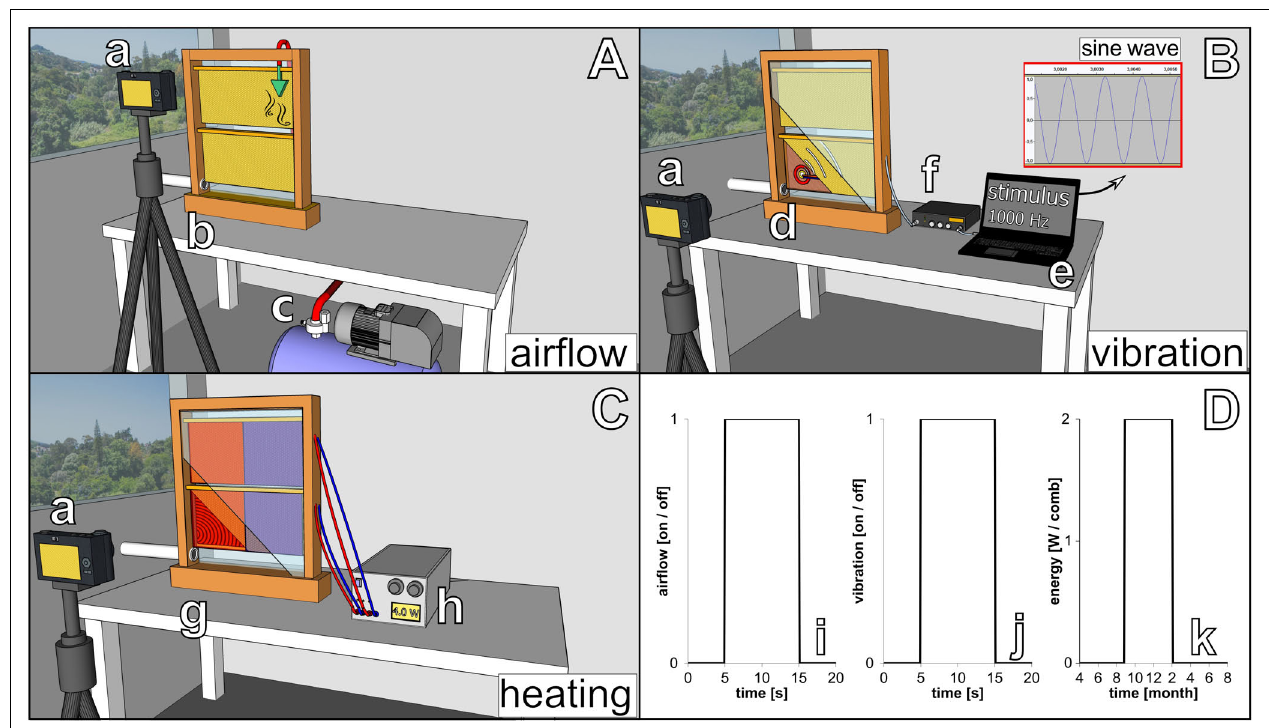
FIGURE 12 | Set-up diagrams of three stimulus types used to influence the decision making of honeybees in a full colony. (A) Set-up for guided dispersal through airflow: (a) camera, (b) observation hive with airflow inlet, and (c) compressor. (B) Set-up for activity modulation by vibration signals: (a) camera, (d) observation hive equipped with piezo transducer, (e) stimulus generator, and (f) amplifier. (C) Set-up for influencing clustering behaviour through temperature signals: (a) camera, (g) observation hive equipped with heating elements, and (h) laboratory power supply. (D) Idealised stimulus time plot of (i) airflow, (j) vibration, and (k) energy input; actuation duration for airflow and vibration was 10 s, for heating 6